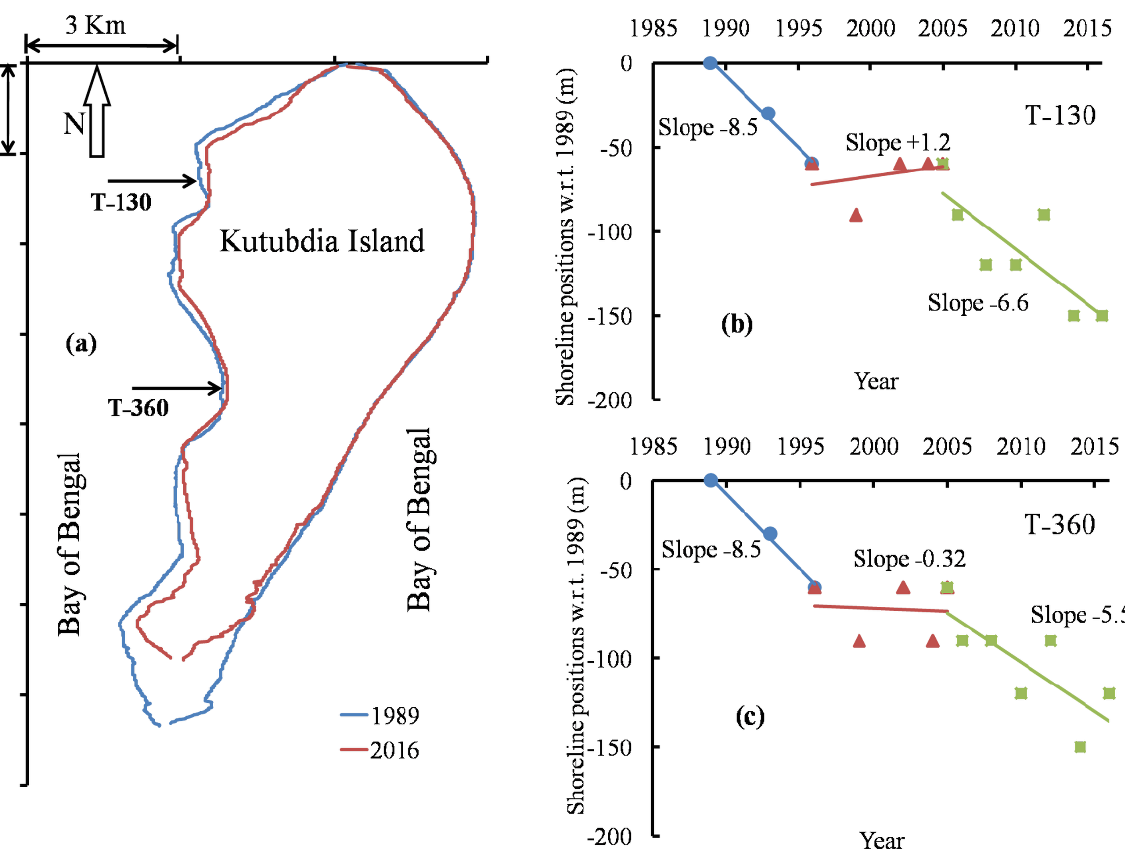
Figure 10. Shoreline positions ( a ) around Kutubdia Island in 2016 (red) and 1989 (blue), ( b ) relative to 1989 for transect T-130, ( c ) relative to 1989 for transect T-360.